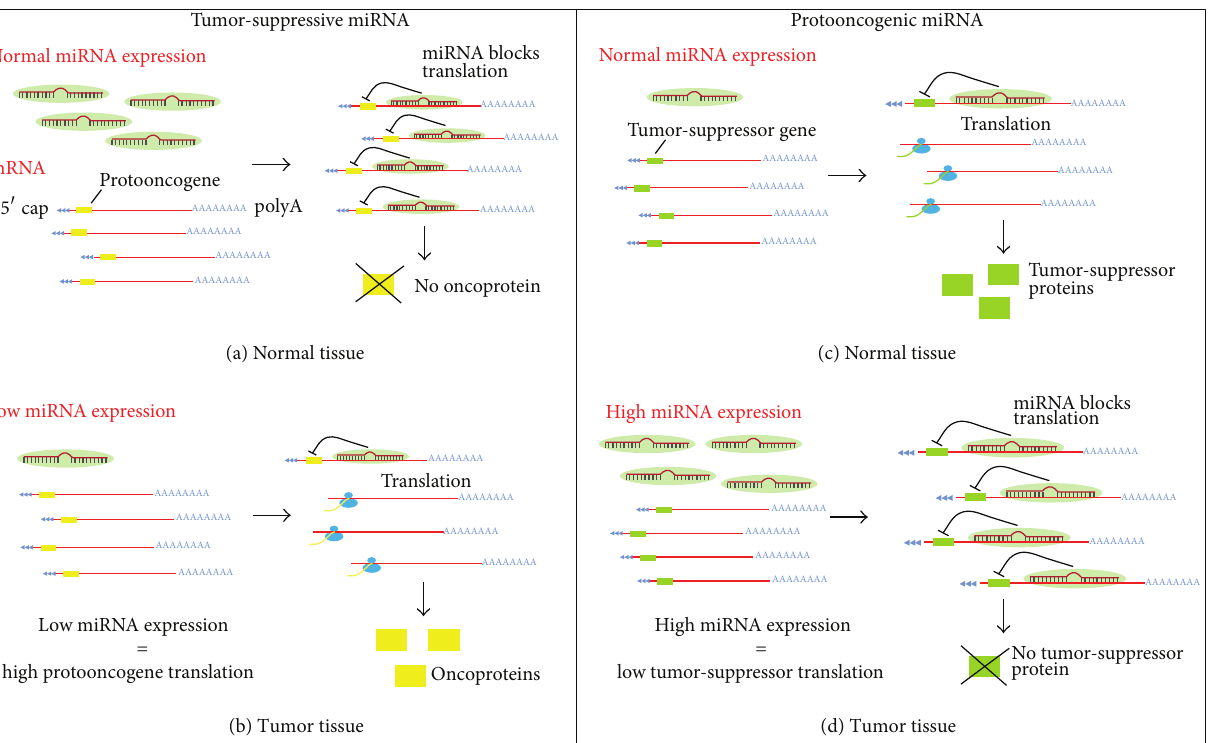
Figure 1: Effect of miRNAs expression on the regulation of protooncogenes and tumor-suppressor genes. Some miRNAs act as negative regulators of protooncogenes expression and therefore their role is tumor-suppression (a). In cancerous tissue, reduced levels of these tumor- suppressive miRNAs lead to increased target oncogenes promoting further tumor development (b). Other miRNAs negatively regulate expression of tumor-suppressor genes; hence, their function is (proto) oncogenic (c). In tumor tissue their increased expression results in blockage of translation of tumor-suppressors further assisting the malignant process